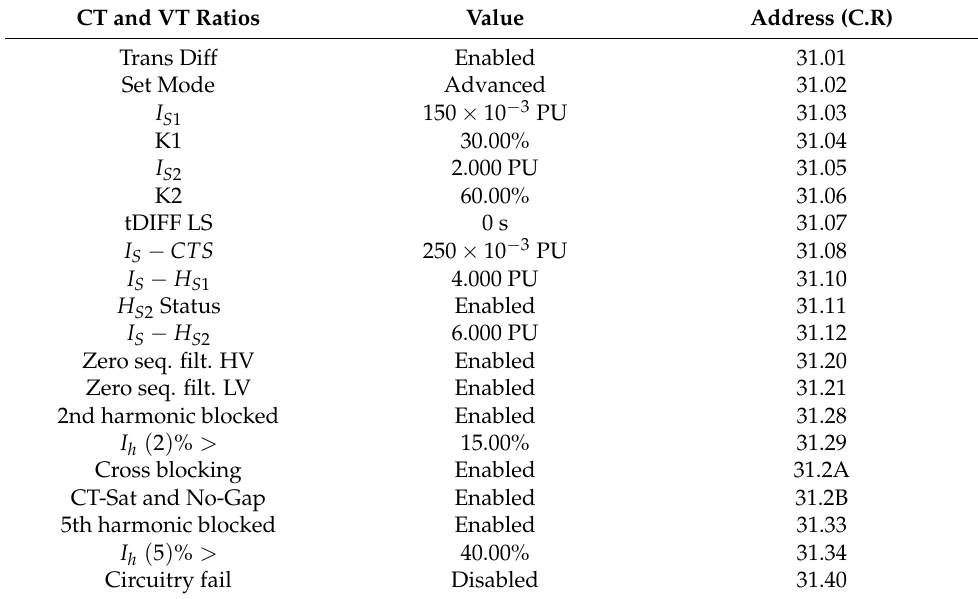
Table 4. Differential protection settings implementation in